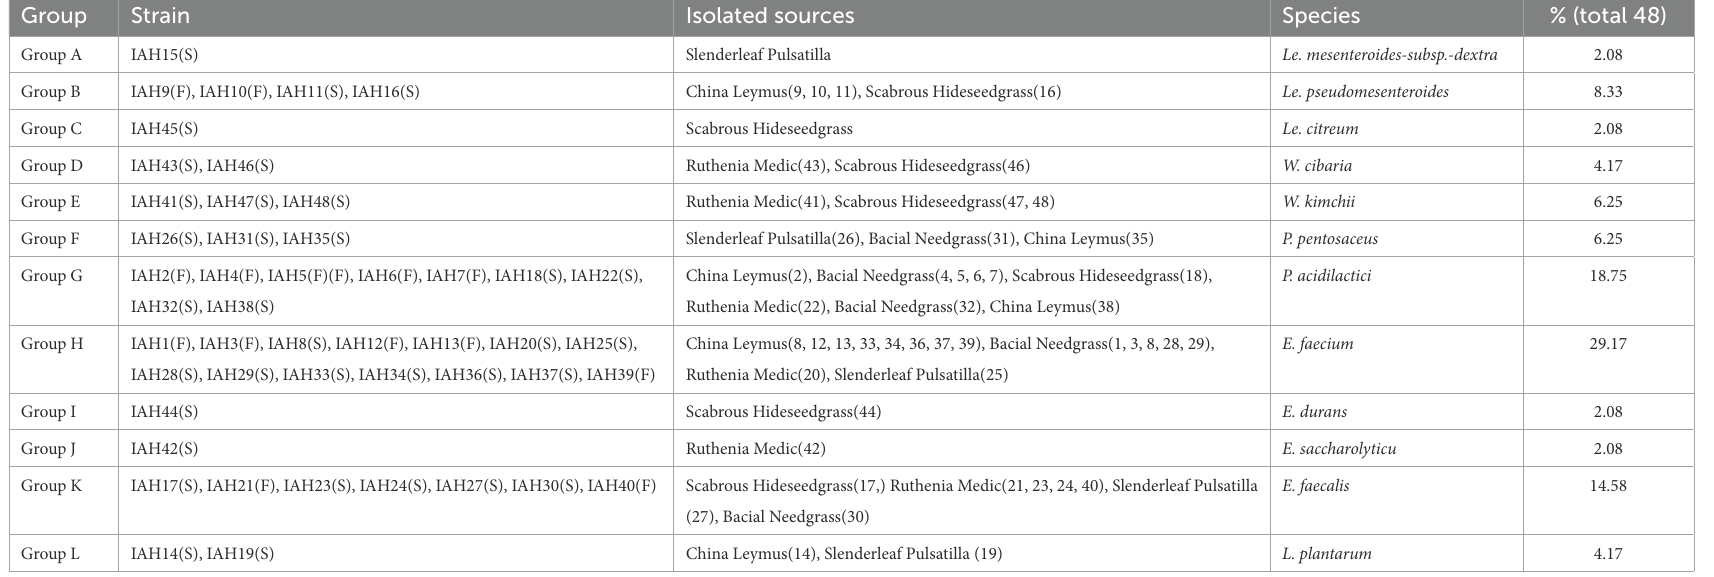
TABLE 7 The strains and source of LAB isolated from native